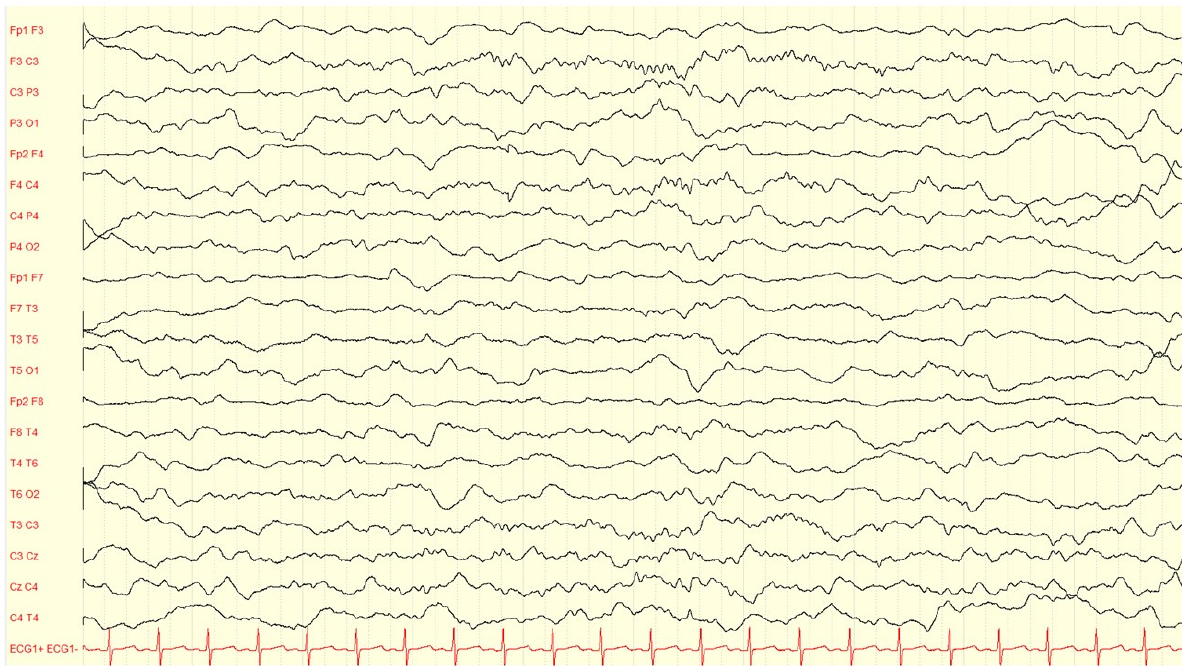
Figure 4. Symmetric spindles in sleep EEG in the same neonate of Figures 2 and 3 at age two months under continued levetiracetam 15 mg/kg/day and pyridoxal phosphate 15 mg/kg/day.